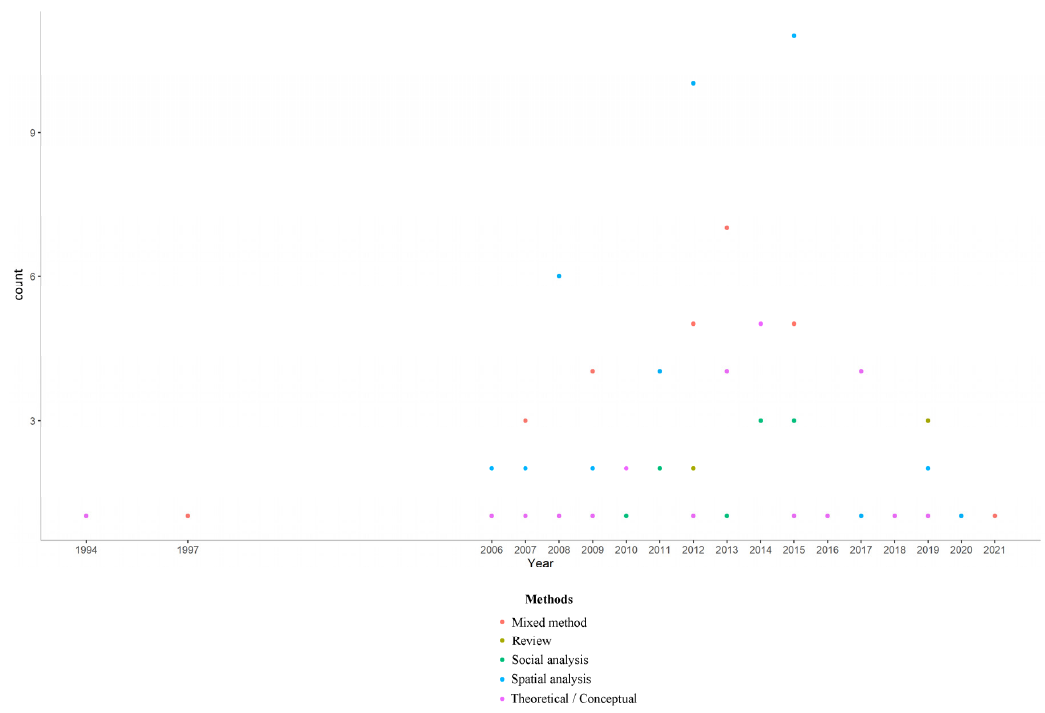
Figure 2. Methods used to assess mountain ecosystem services in the analyzed papers.